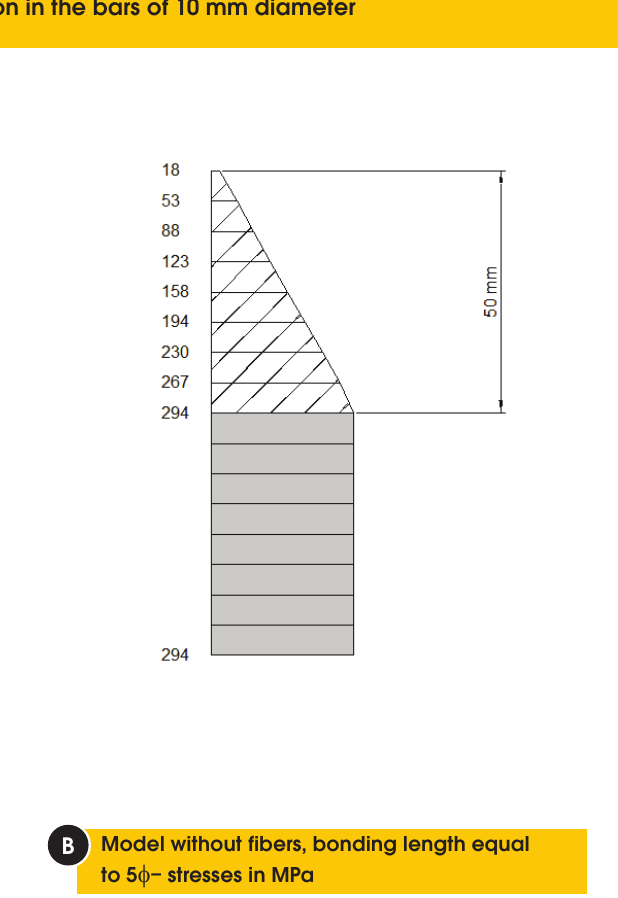
Figure 11 – Tensile stress distribution in the bars of 10 mm diameter